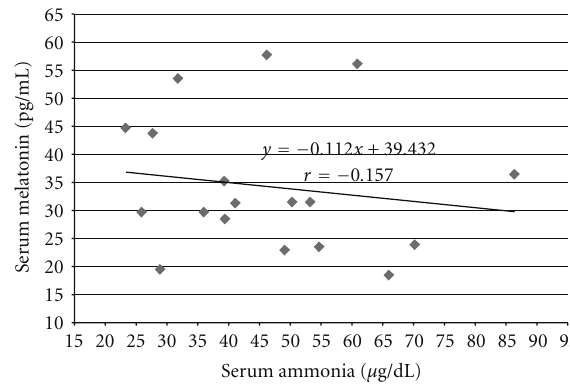
Figure 2: Correlation between ammonia and melatonin serum levels in cirrhotic patients with 1st degree of hepatic encephalopathy (group HE 1 ) according to West-Haven Score; y : regression equa- tion, r : correlation coe ffi cient, statistically